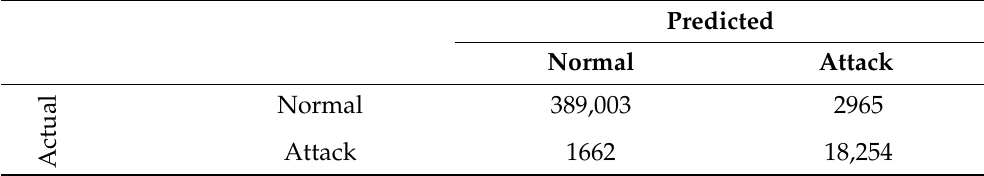
Table 14. Confusion matrix for UNSW-NB15 “full features” binary classification experiment.